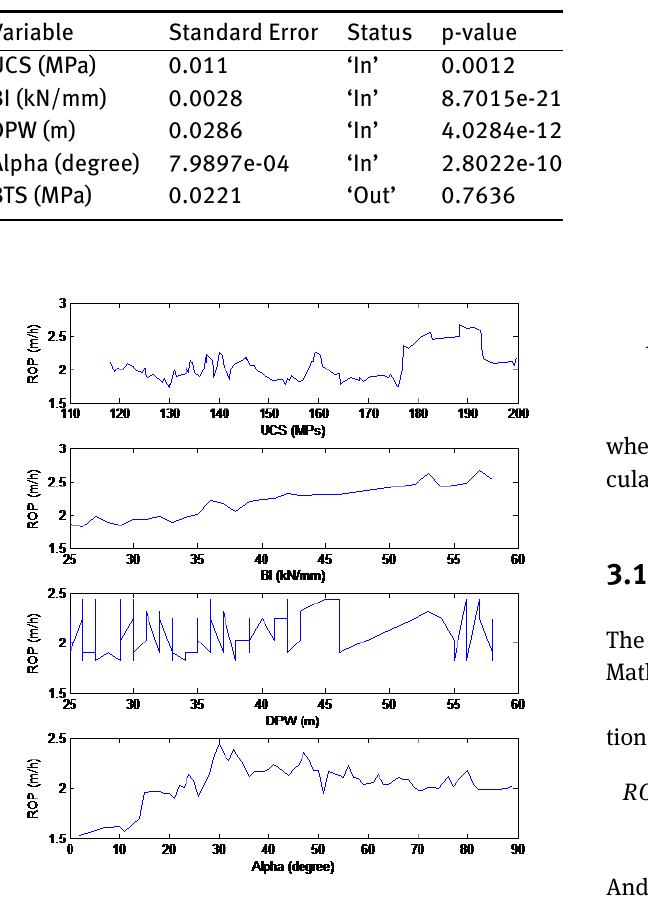
Table 1: Results of stepwise test.